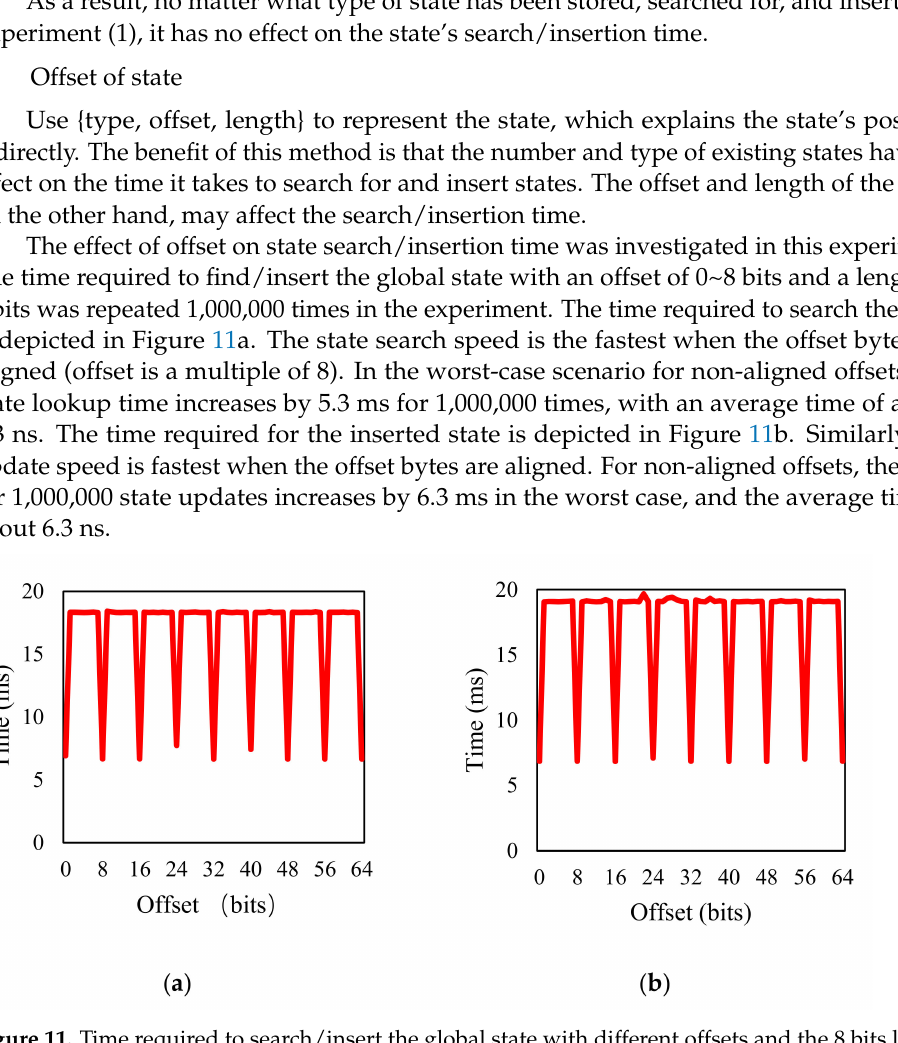
Figure 11. Time required to search/insert the global state with different offsets and the 8 bits length 1,000,000 times. ( a ) Search state. ( b ) Insert